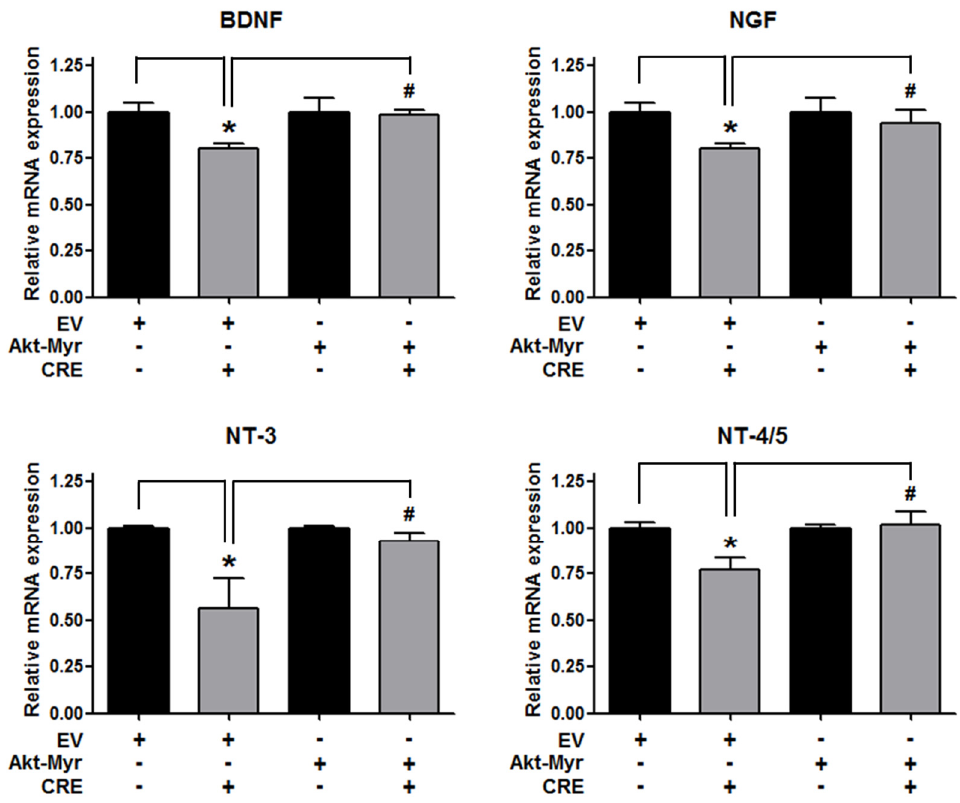
Figure 5. Involvement of the Akt pathway in the expression of neurotrophins in endometriotic cells. The 12Z cells were transfected with an empty vector (EV) or a constitutive active form (Akt-Myr), and then the cells were treated with CRE (100 µg/mL). After 24 h, real-time RT-PCR was performed to measure the mRNA expression of BDNF, NGF, NT-3 and NT-4/5. The expression levels were normalized to GAPDH. * p < 0.05 compared with EV-transfected none treatment group and # p < 0.05 compared with EV-transfected CRE treatment group.